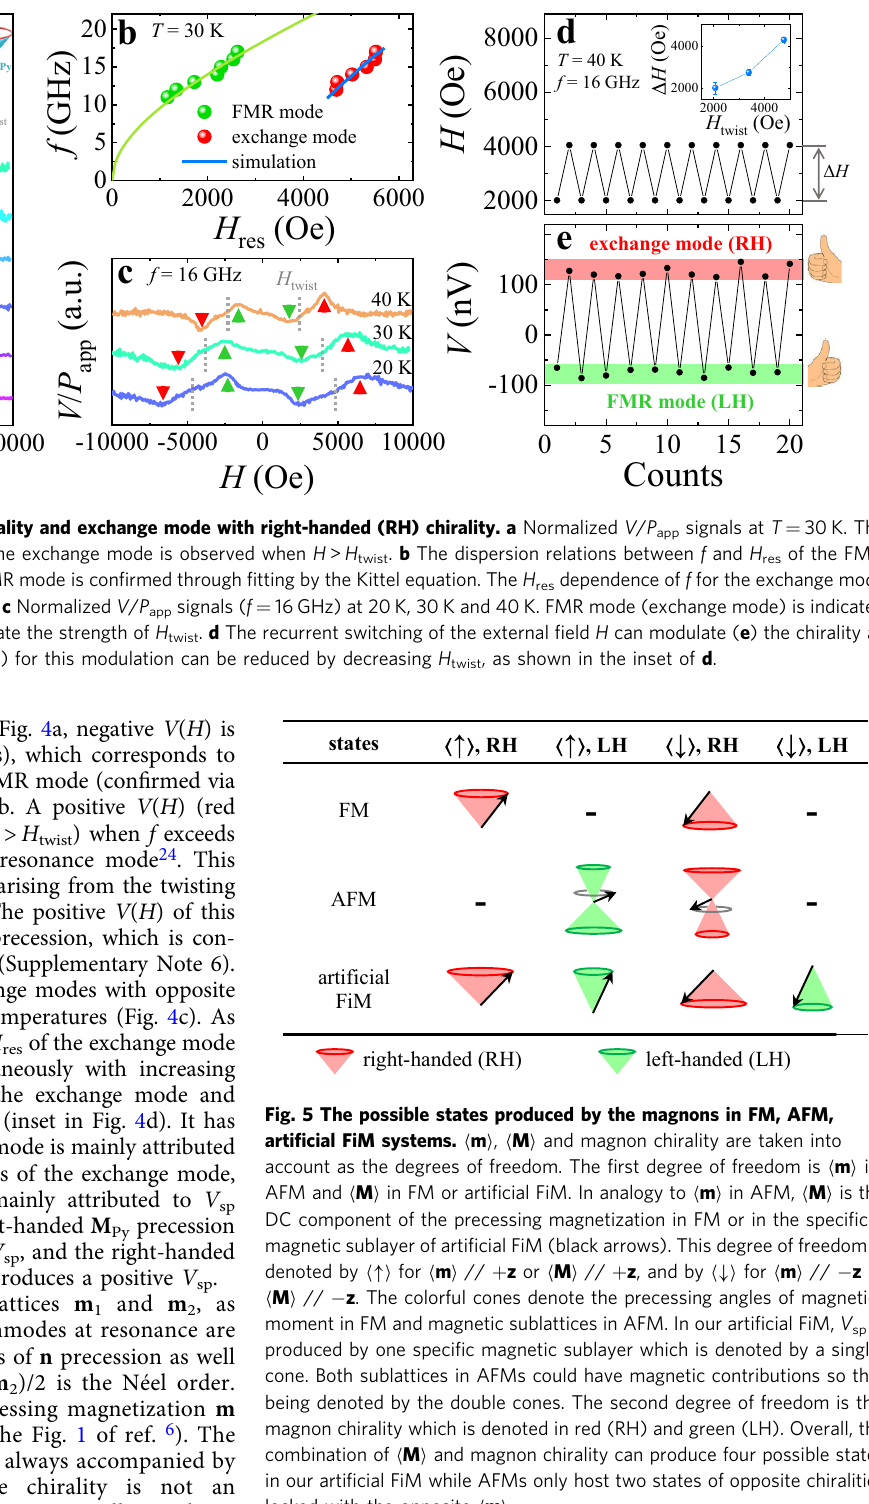
Fig. 5 The possible states produced by the magnons in FM, AFM, arti fi cial FiM systems. h m i , h M i and magnon chirality are taken into account as the degrees of freedom. The fi rst degree of freedom is h m i in AFM and h M i in FM or arti fi cial FiM. In analogy to h m i in AFM, h M i is the DC component of the precessing magnetization in FM or in the speci fi c magnetic sublayer of arti fi cial FiM (black arrows). This degree of freedom is denoted by h"i for h m i // + z or h M i // + z , and by h#i for h m i // − z or h M i // − z . The colorful cones denote the precessing angles of magnetic moment in FM and magnetic sublattices in AFM. In our arti fi cial FiM, V sp is produced by one speci fi c magnetic sublayer which is denoted by a single cone. Both sublattices in AFMs could have magnetic contributions so that being denoted by the double cones. The second degree of freedom is the magnon chirality which is denoted in red (RH) and green (LH). Overall, the combination of h M i and magnon chirality can produce four possible states in our arti fi cial FiM while AFMs only host two states of opposite chiralities locked with the opposite h m i